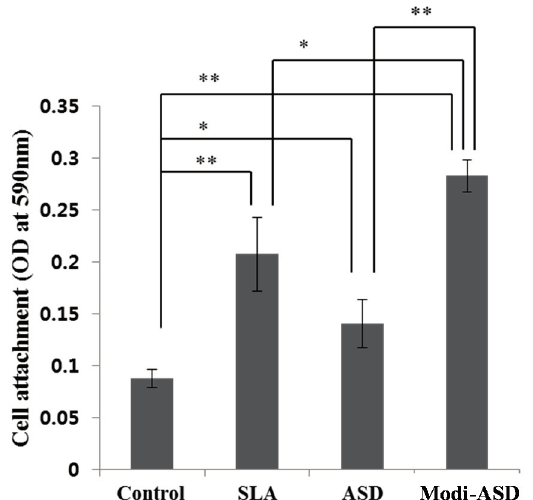
Figure 2. Cell adhesion of MG-63 cells cultured on titanium substrates. Crystal violet assays were performed after incubating MG-63 cells on each Ti surface for 3 h. * p < 0.05 and ** p < 0.01 indicate statistical significant between